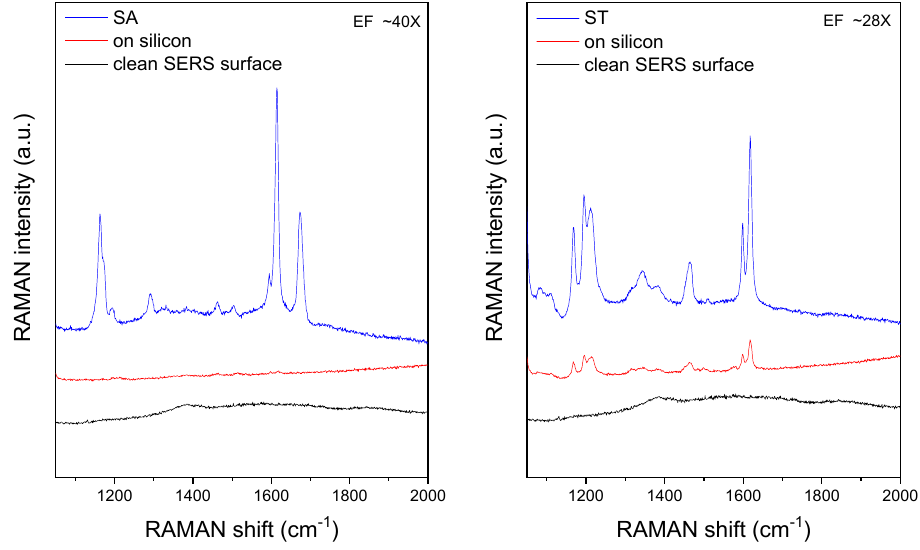
Figure 7. Comparison of SERS spectra recorded on pristine SERS substrate, as well as of different fluorescent beads on silicon surface and entrapped in the periodic array.